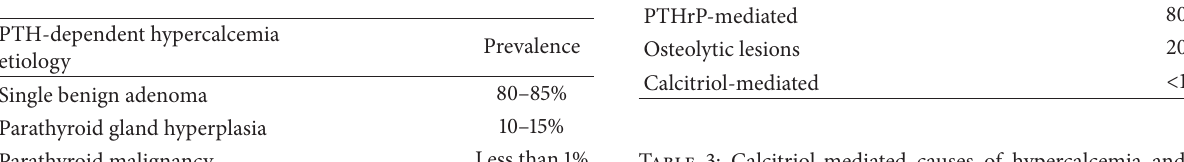
Table 1: PTH-dependent hypercalcemia etiologies and percent of occurrence. Parathyroid gland hyperplasia includes the multi- ple endocrine neoplasia (MEN) syndromes, hyperparathyroid jaw tumor syndrome, and familial isolated hyperparathyroidism. Rarely, primary parathyroid gland malignancy is the cause [3].